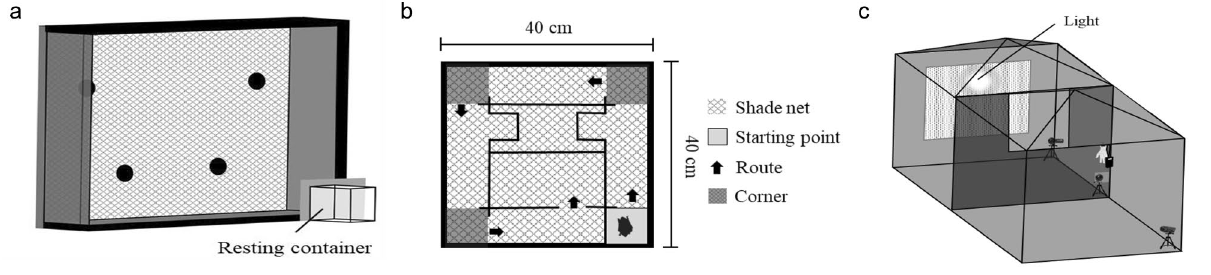
Fig. 1 Experimental test devices: (a) hole-board box, (b) tunnel box, and (c)